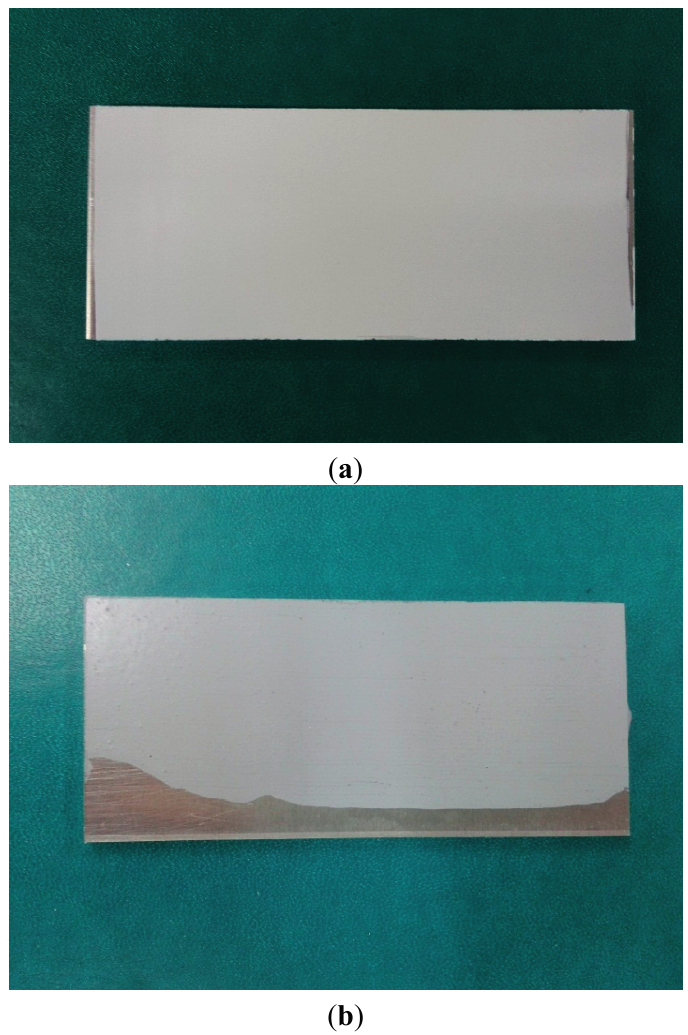
Figure 2. AA 2024-T3 aluminium alloy coated with epoxy resin ( a ) and graphene/epoxy resin ( b